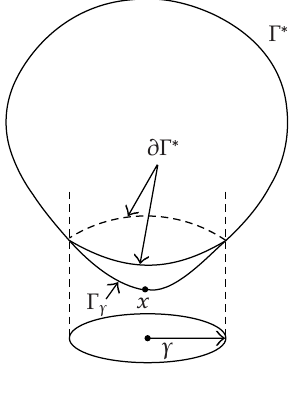
Figure 3.1. Convex